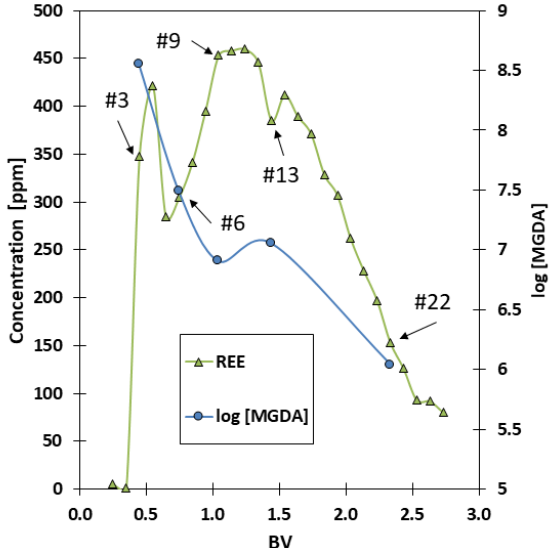
Figure 10. Chromatogram of the experiment as ∑ REE with the corresponding logarithmic values of [MGDA]. (flowrate = 2.98 BV/h; feed (#2) = 0.05 BV, eluent = 50 mM HCl; T = 20 °C).